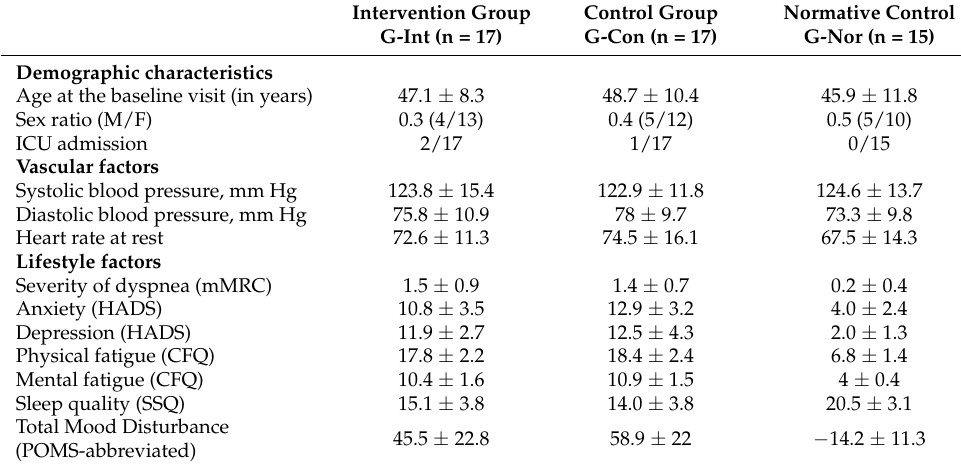
Table 1. Main demographic and clinical characteristics of the study sample at baseline. Descriptive statistics are expressed as mean ± standard deviation (SD).